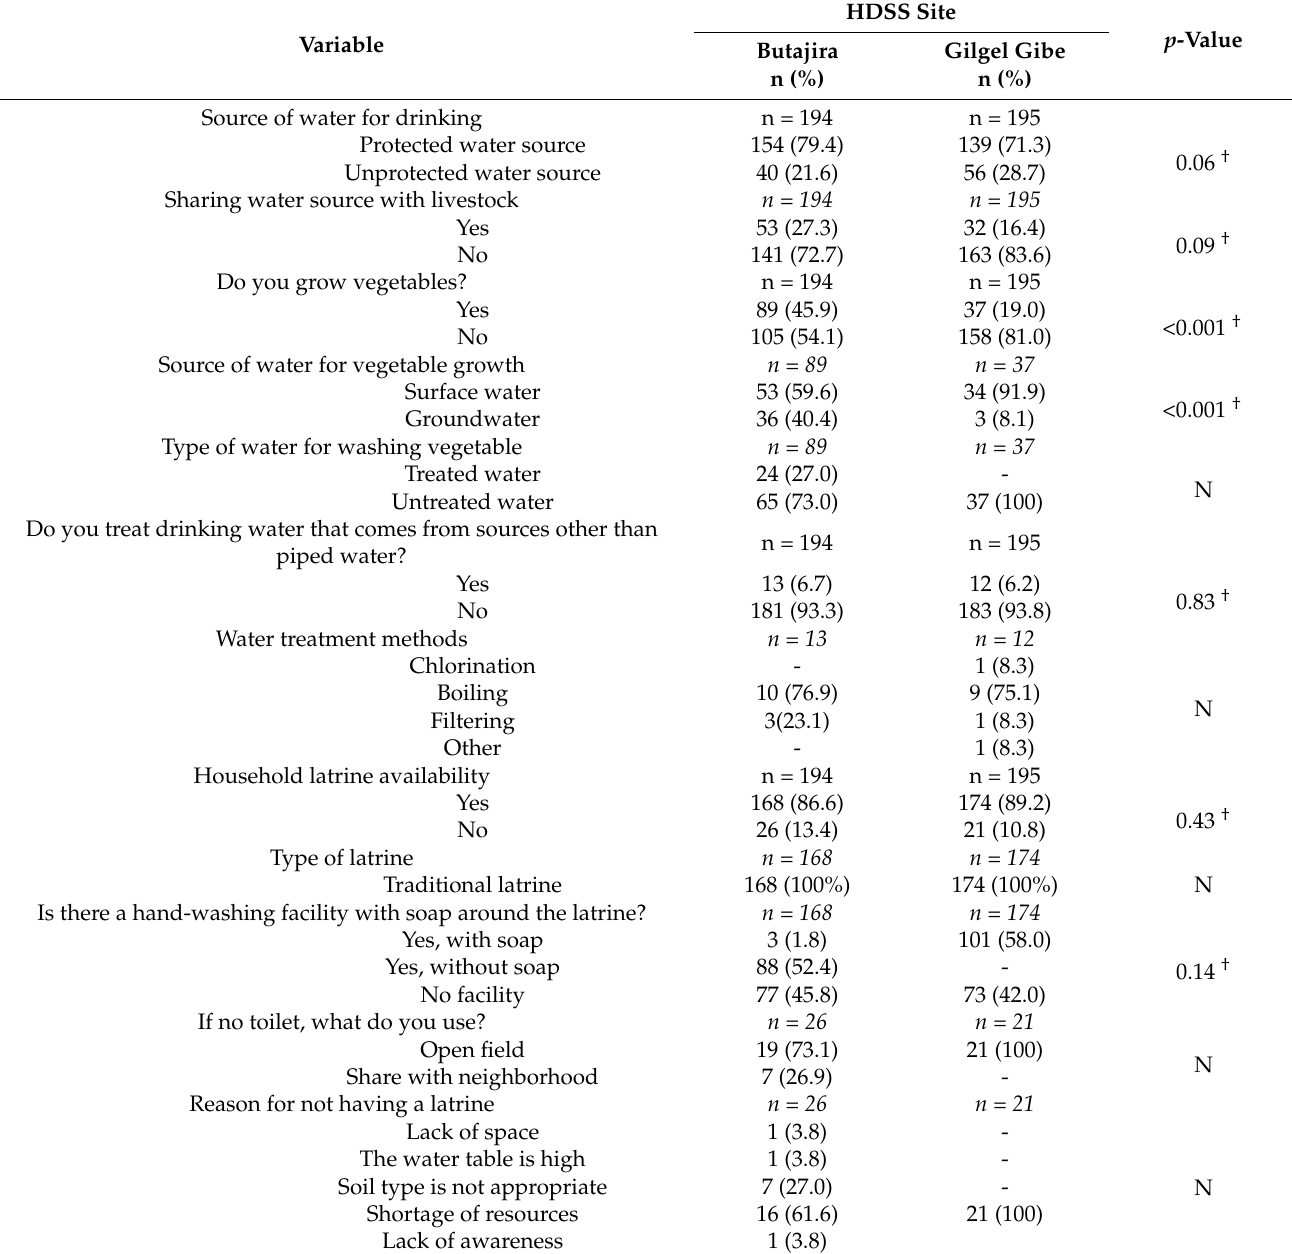
Table 3. Environmental characteristics of households in a study of fasciolosis in the Butajira and Gilgel Gibe HDSS sites,